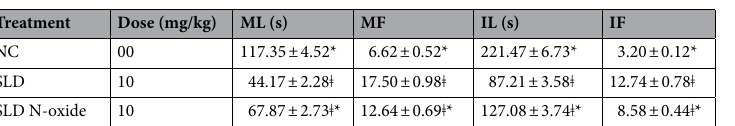
Table 7. Effect of SLD and SLD N-oxide on mount latency and frequency and intromission latency and frequency of male rats (n = 6). ǂ Indicate significance in comparison to NC group at p < 0.05. *Indicate significance in comparison to SLD group at p < 0.05.